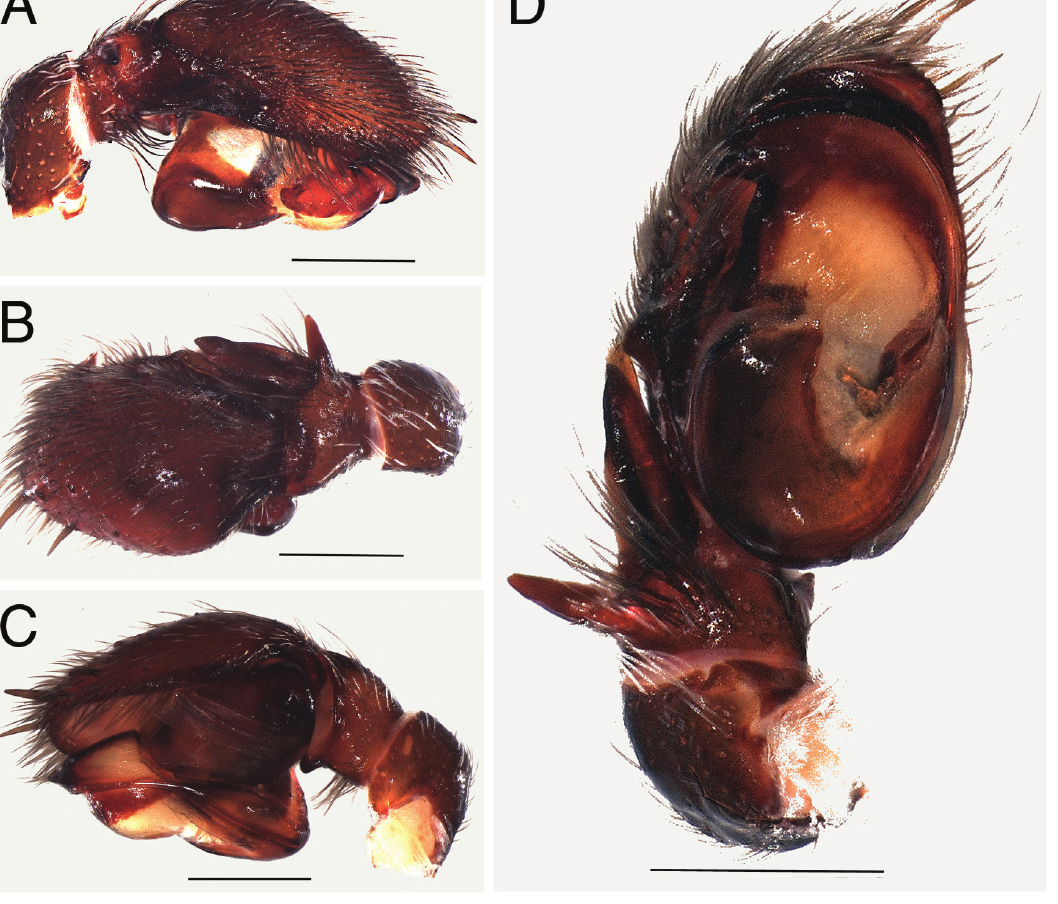
Fig. 12. Palindroma obmoimiombo gen. et sp. nov., holotype, ♂ (MRAC 241633). A . Palp, retrolateral view. B . Idem, dorsal view. C . Idem, prolateral view. D . Idem, ventral view. Scale bars = 0.5